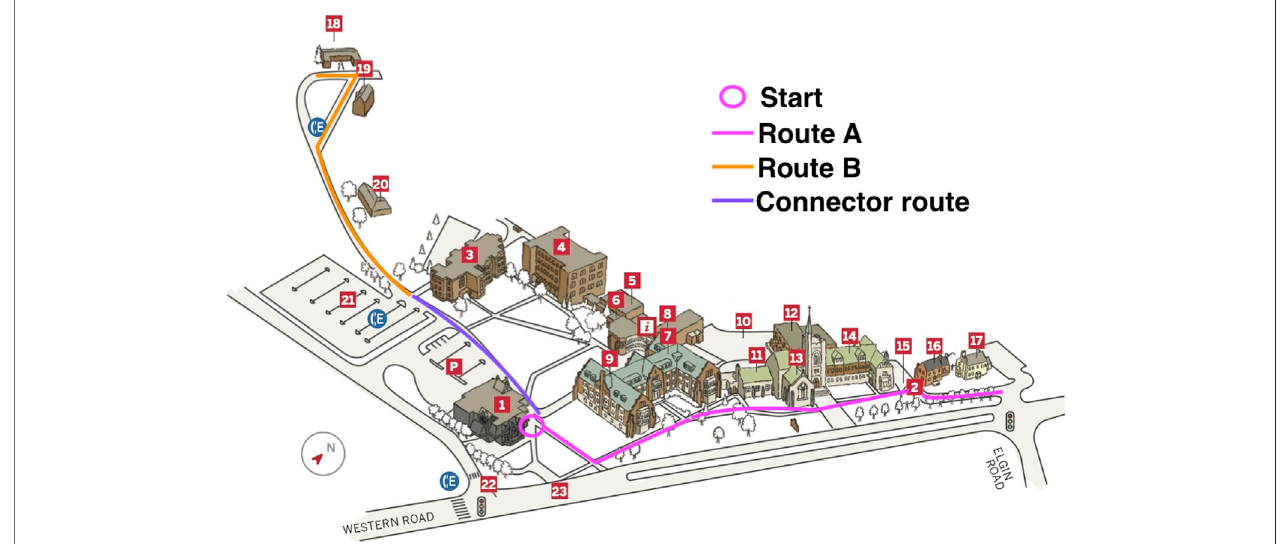
FIGURE 4 | Map of the Huron University College campus showing the starting point, routes A and B, and the connector route. Buildings 3, 20, 19, and 18 were landmarks on route A, and buildings 1, 9, 13, and 16 were landmarks on route B. Adapted from Huron ’ s Campus Map, by Huron University College, 2021 (https:// huronatwestern.ca/form-centre/hurons-campus-map/). Copyright 2021 by Huron University College. Adapted with permission.